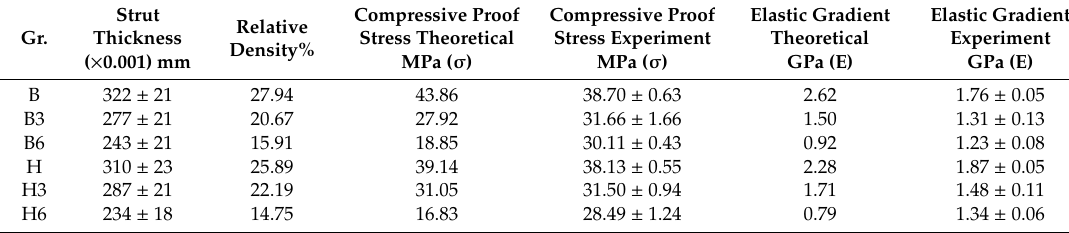
Table 3. Comparison of strut thickness and mechanical parameters measured and predicted by the analytic model for the specimen batches subjected to various postprocessing methods.